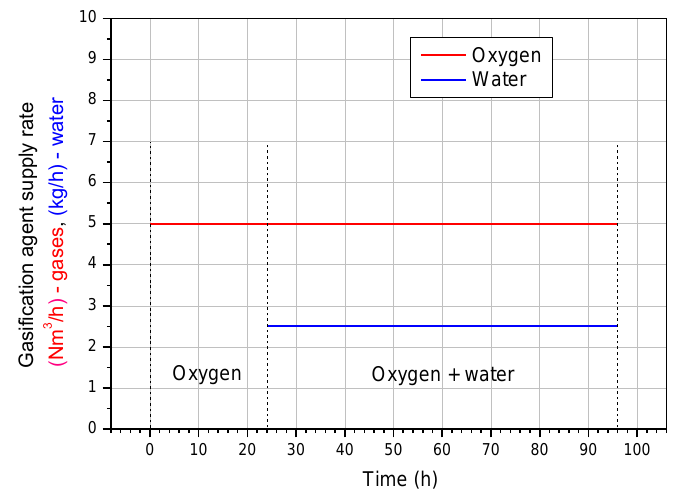
Figure 3. Supply rates of the gasification reagents during the UCG tests.